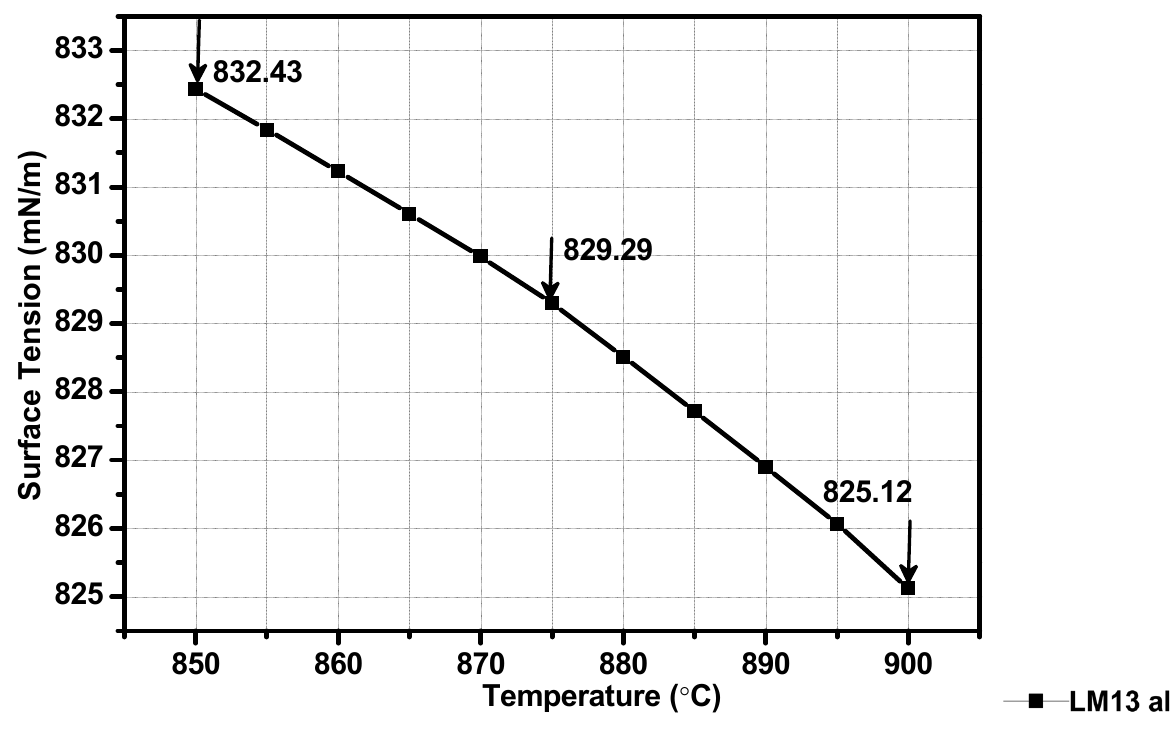
Figure 7. The effect of foaming temperature on the surface tension of the LM13 alloy composite foams. The viscosity and stability of bubbles are affected by the foaming temperature. How- ever, the wettability of the solid and liquid phases impacts the thickening and bubble stability of the mixture [29]. The energy balance at the melt–zircon particle interface deter- mines the location and distribution of zircon particles on the cell wall and node. The effect of gas reactions on the cell wall surface and the number of ceramic particles responsible for increasing foamability have been studied. The viscosity of the liquid Al-Si12CuFe alloy increased when 5 wt.% ceramic particles were added. The decomposition of CaCO 3 under these conditions resulted in lower released gas pressure than that with the Al-Si12CuFe alloy as a starting point. The bubble-like structure is formed when CO 2 gas expands inside the liquid alloy [30]. The reinforced ceramic particles strengthen the cell wall. At 850 ◦ C, a mixture of 2 wt.% blowing agent and 5 wt.% ceramic particles failed to produce enough pressure to produce composite foam with uniform cell size (Figure 5a). The cell size, porosity and viscosity of the Al-Si12CuFe alloy composite foam sample are observed to change as a function of foaming temperature. Because of the small amount of CO 2 gas agent degradation and liquid surface tension [31]. Viscosity and surface tension